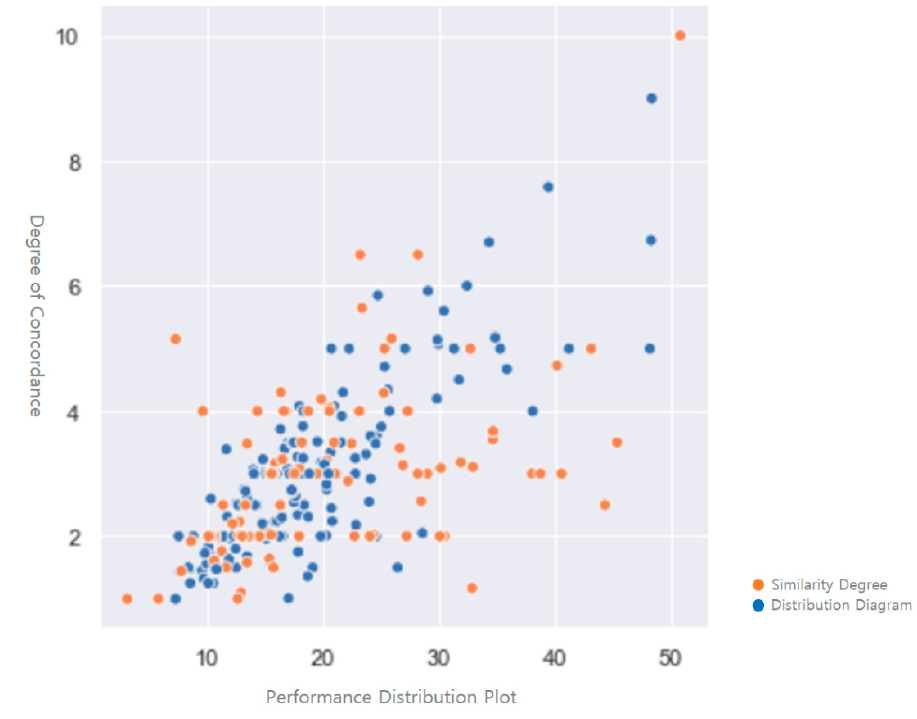
Figure 10. Results of distribution and similarity measurement.